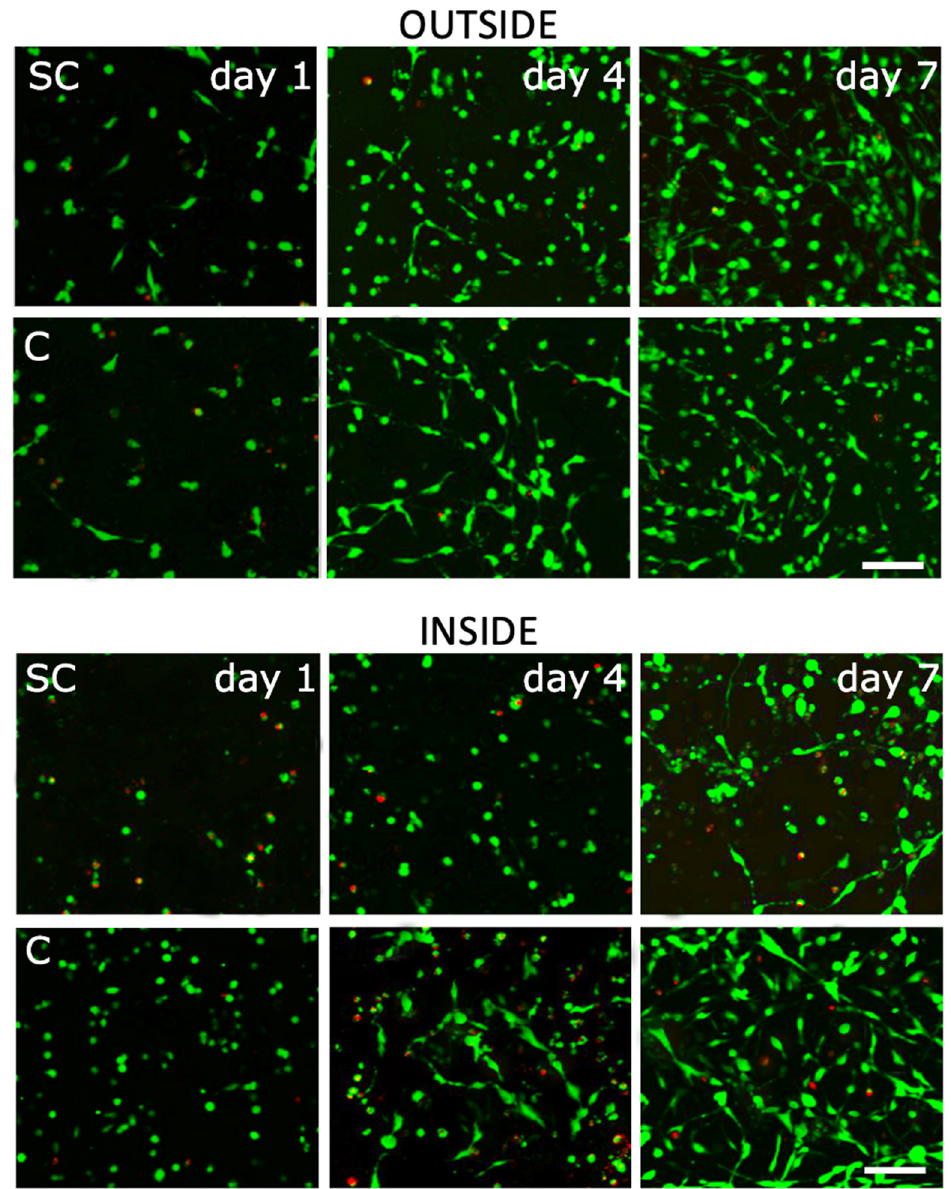
Figure 9. Fluorescence images of live and dead bone osteoblasts on scaffolds of the 1st, 4th and 7th test days comparing the effect of the internal printing of selected bioink and scaffold without bioink on the viability of human osteoblasts—live cells (green: Calcein AM) and dead cells (red: EthD ‐ I) staining. The scale is 100 μ m. The top section shows surface cell proliferation—OUTSIDE. The bottom part shows internal cell proliferation (3 mm under the surface)—INSIDE. C—Hydrogel with incorporated collagen, SC—scaffold with conventionally seeded cells.